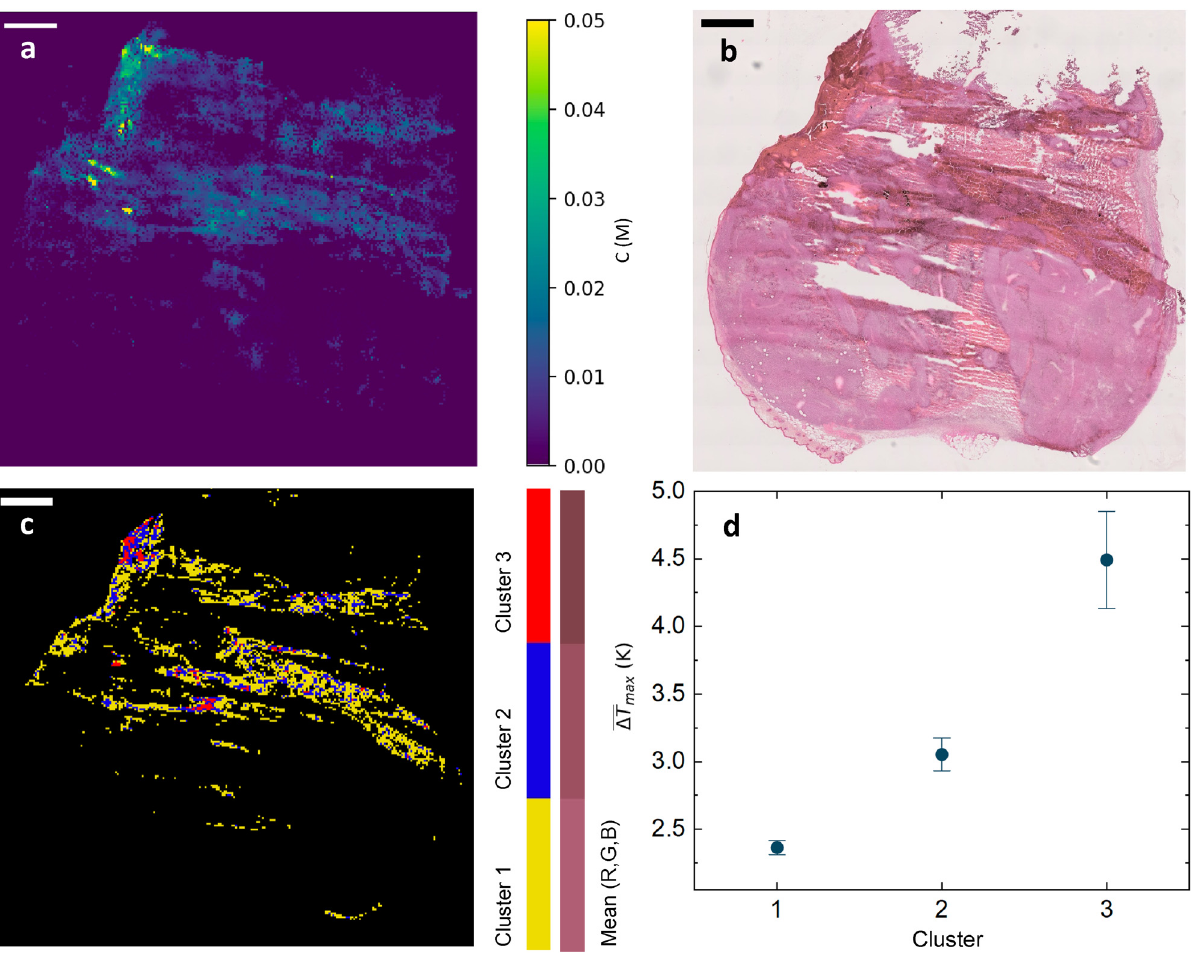
Figure 5: Quanti fi cation of the melanin concentration. ( a ) Super - resolution image of the absolute melanin molar concentration C retrieved from Figure 1a by the pixel - wise conversion C T m Δ max = / ( m 254 K M = / ) . ( b ) H&E image of the same biopsy imaged in Figure 1a and b. The H&E staining has been performed upon completion of super - resolution thermal imaging experiments on the unstained biopsy. ( c ) Results of our 2 - means lightness - driven clustering applied to the H&E image of panel ( b ) . Pixels in clusters 1, 2, and 3 ( color - coded in yellow, blue, and red, respectively ) have been selected by three consecutive iterations right before convergence ( note that cluster 1 contains clusters 2 and 3, and cluster 2 contains cluster 3 ) , and are associated with increasingly low mean ( R,G,B ) values: R for cluster 3. The corresponding mean ( R ¯ , G ¯ , B ¯ ) colors are shown in the right color - bar for visual reference. ( c ) Average amplitude T Δ max of the temperature increments measured in those pixels of Figure 1a classi fi ed as belonging to cluster 1 ( left ) , cluster 2 ( center ) , and cluster 3 ( right ) ; error bars correspond to the 95% con fi dence